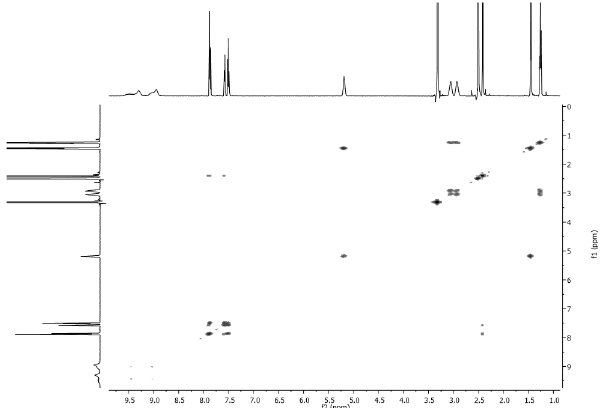
Figure 13. COSY spectrum of 3-MEC ( 4 ); 500MHz, DMSO-d 6 , RT.